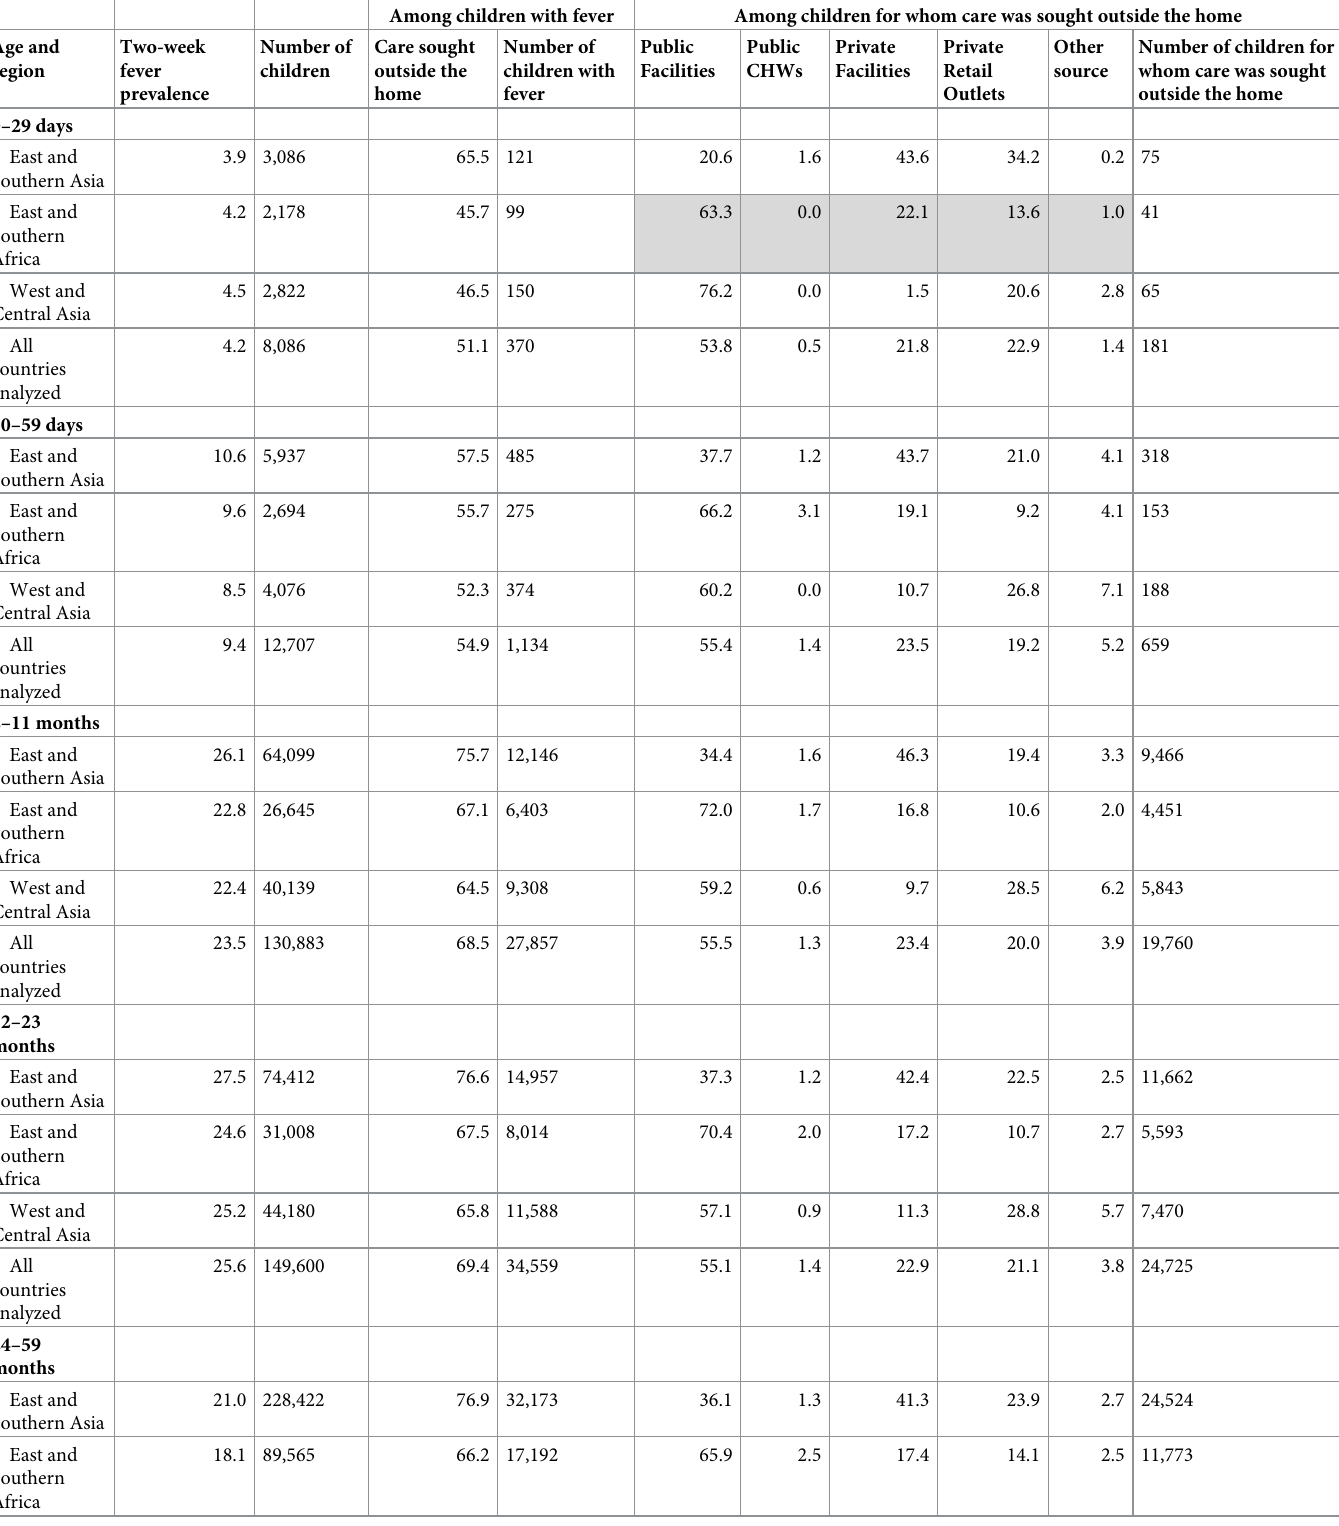
Table 4. Fever prevalence, care-seeking level, and sources of care by child’s age and region. Among children with fever Among children for whom care was sought outside the